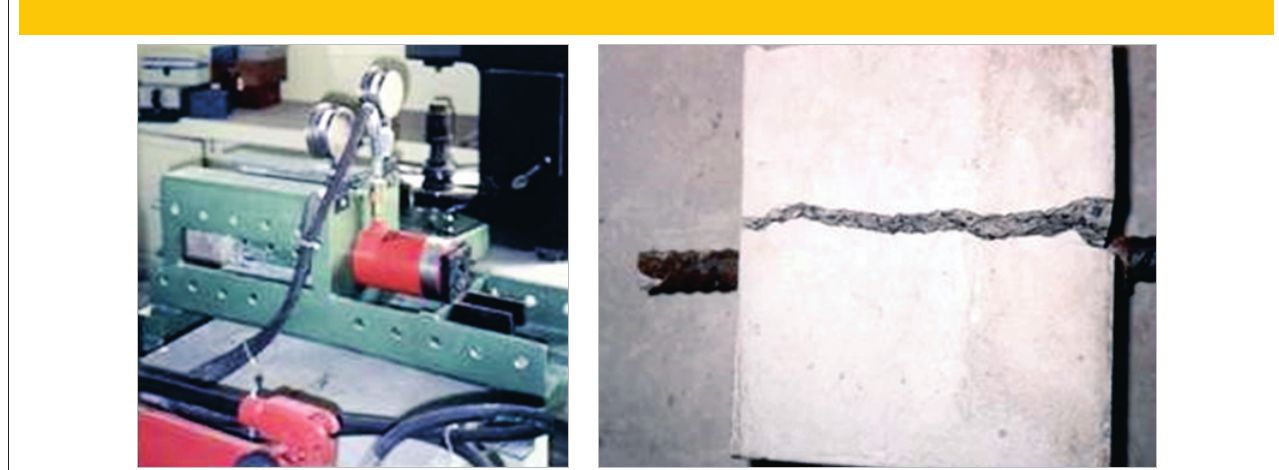
Figure 4 – Test apparatus and fractured